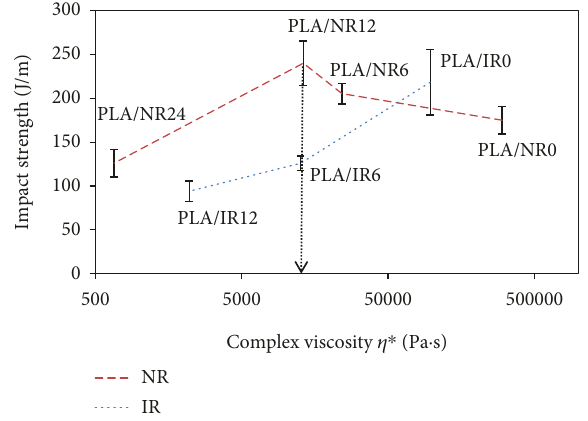
Figure 13: Complex viscosities of NR and IR with various mastication times versus impact strength at